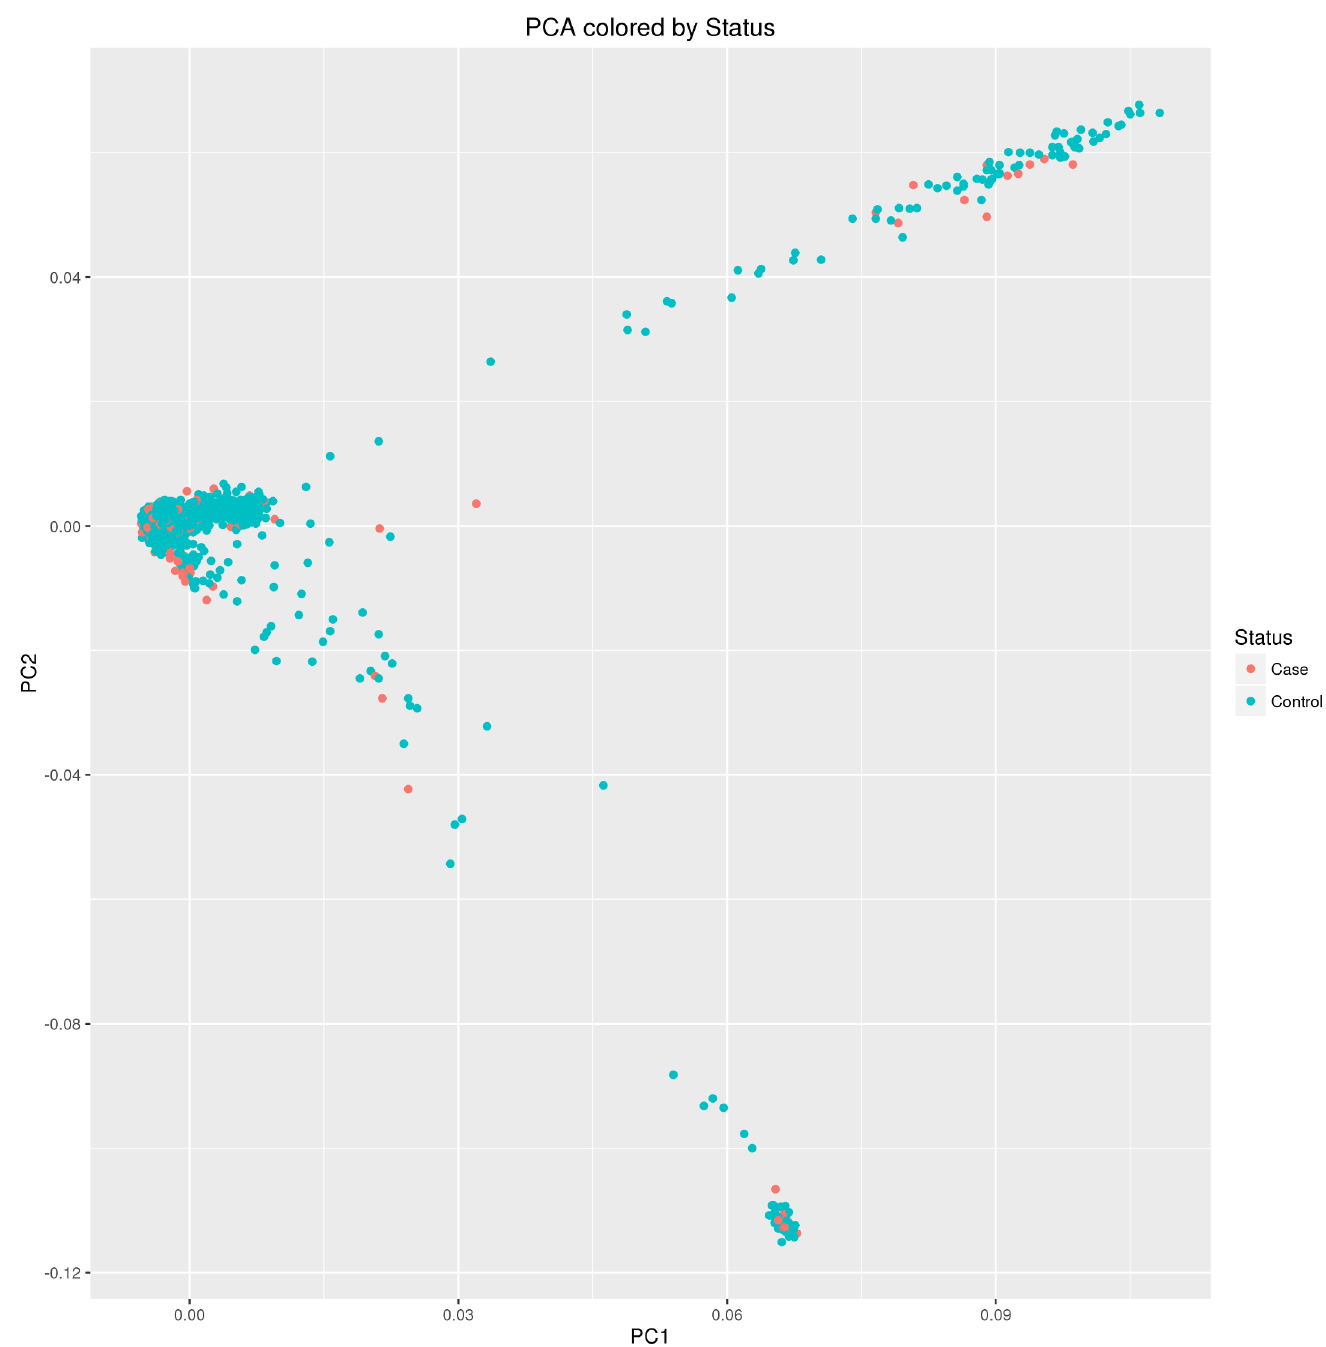
Fig 8. Principal component analysis (PCA) of 5090 samples (glaucoma cases and controls) from eMERGE network. Eigenvector 1 is on x-axis and eigenvector 2 is on y-axis. Each point is a sample and they are color coded by case and control